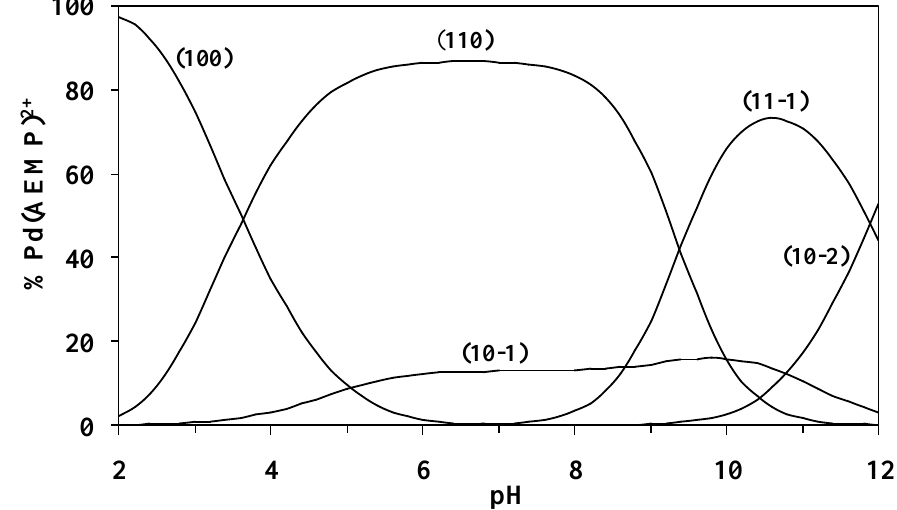
Figure 2. Concentration distribution of various species as a function of pH in the Pd(AEMP)-Threonine system at a concentration of 1.25 mM for [Pd(AEMP)(H 2 O) 2 ] 2+ and threonine.